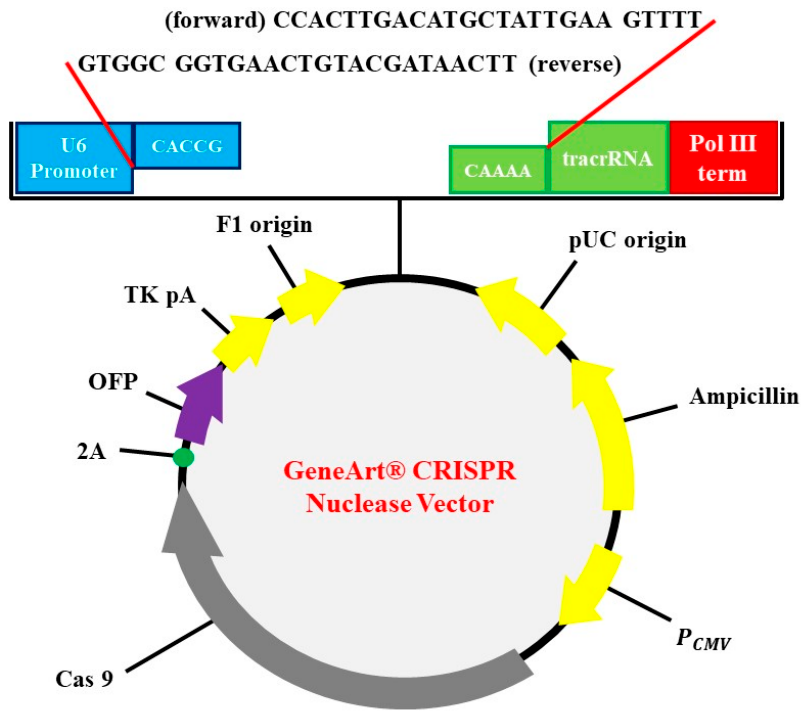
Figure 1. Identification of plasmid. CRISPR-HGF plasmid vector map and 20 base nucleotides of sgRNA insertion. It is referred to by previous research [16]. The diagram represents vector map of CRISPR/Cas9 vector, GeneArt CRISPR Nuclease vector (9219 bp). The guide RNA (gRNA) ligation was enabled by using BbsI as a restriction enzyme. U6 promoter, orange fluorescent protein (OFP), CMV enhancer, gRNA scaffold, Cas9, and ampicillin resistant gene (AmpR) are included in the sequence elements.